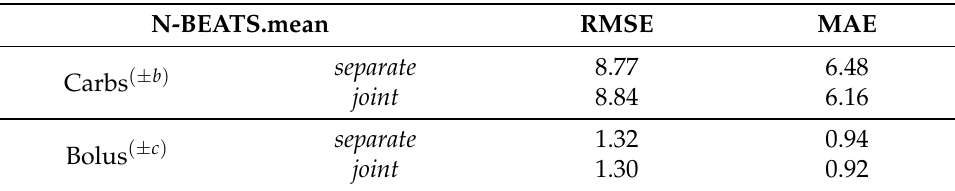
Table 8. N-BEATS-based model results, with a separate vs. joint final fully connected layer for computing backcast and forecast